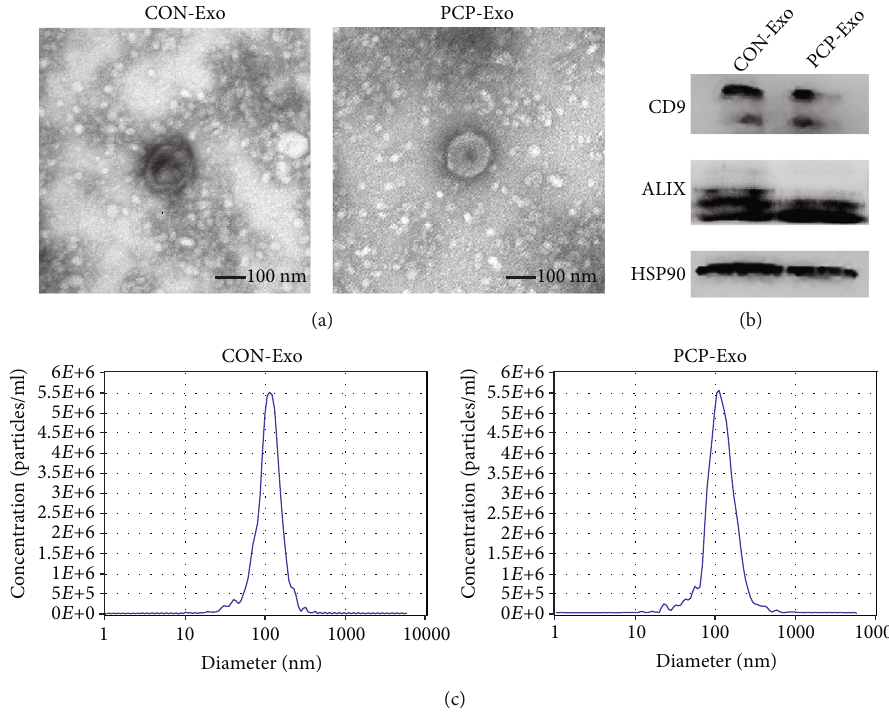
Figure 2: Exosome isolation and characterization. Exosomes were isolated from the culture medium of lung B cells from uninfected and Pneumocystis- infected mice (8 – 10 mice per group). (a) Electron microscopy images of exosomes. Scale bar represents 100 nm. (b) Immunoblot analysis of B cell exosomes for exosomal markers CD9, ALIX, and HSP90. (c) Size distribution of particles analyzed by nanoparticle tracking analysis. CON: uninfected control mice; PCP: Pneumocystis pneumonia mice; Exo: